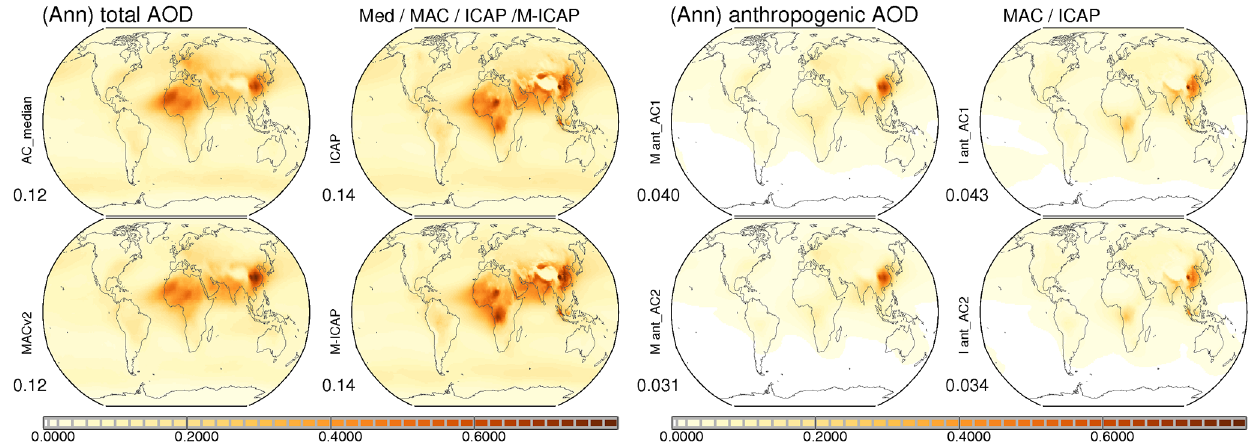
Figure 20. Uncertainty estimates for present-day total and anthropogenic AOD from different realizations. Annual maps for tropospheric total AOD (left frame) and for anthropogenic AOD (right frame) are shown. Total AOD maps compare model ensemble data of AeroCom1 experiments (left column) and ICAP satellite data assimilations (right column), before (top) and after (bottom) the data merging with sun- photometer data. Anthropogenic AOD maps are the result of applying the two different anthropogenic fractions (based on emissions by Dentener – AC1 – and Lamarque – AC2) to the fine-mode AOD of the AERONET adjusted maps. Values below the label show global